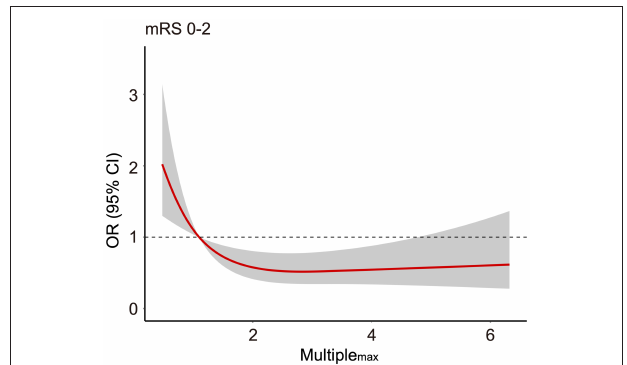
FIGURE 2 | The association between Multiple max and the odds ratio for favorable prognosis (90-day modified Rankin scale scores 0–2). Adjusted for age, median NIHSS score at 24h, pneumonia, and glucose level. mRS, modified Rankin scale; OR, odds ratio; NIHSS, National Institute of Health Stroke